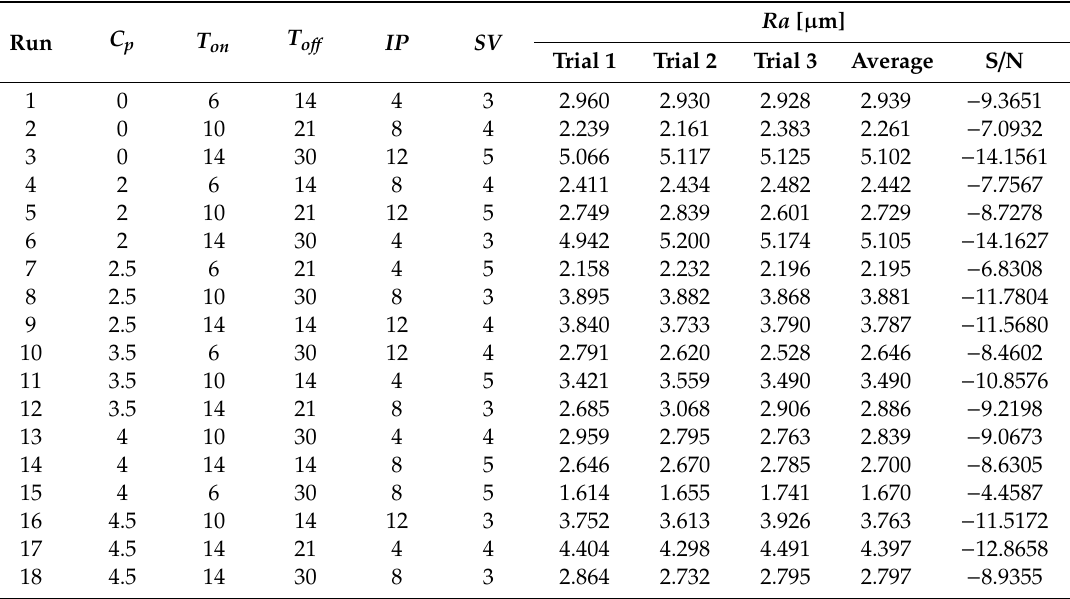
Figure 5. The process of the experimental design using Minitab software. Table 4. The results of PMEDM process.